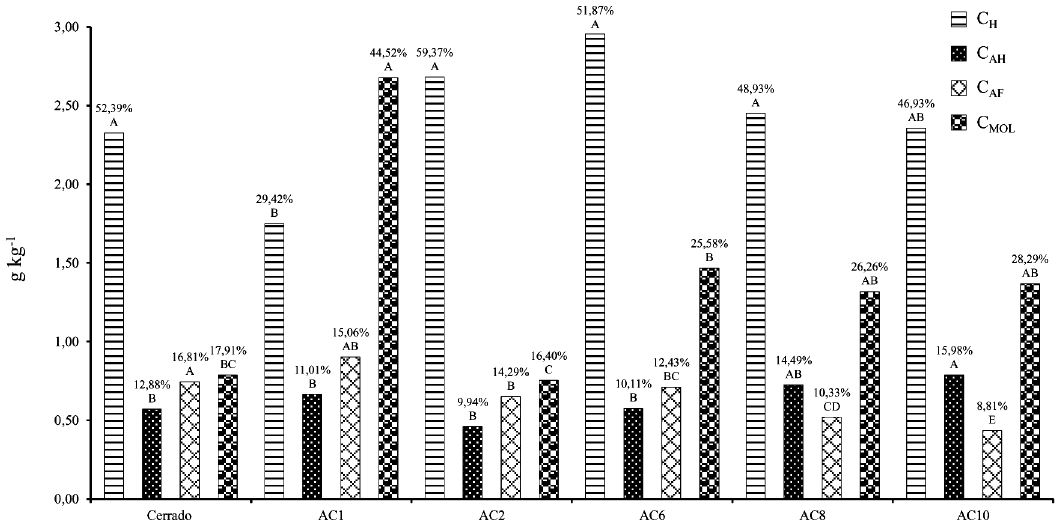
Figura 3. Distribuição de carbono na forma de humina (C H ), carbono na forma de ácidos húmicos (C AH ), carbono na forma de ácidos fúlvicos (C AF ) e carbono na forma de matéria orgânica leve (C MOL ), na profundidade de 0-20 cm de um Neossolo Quartzarênico, em diferentes áreas de cultivo de soja e milheto. AC1: área de cultivo com um ano, AC2: área de cultivo com dois anos, AC6: área de cultivo com seis anos, AC8: área de cultivo com oito anos, e AC10: área de cultivo com 10 anos. Médias não seguidas pela mesma letra maiúscula, entre as épocas e para cada fração, diferem estatisticamente entre si pelo teste Mann- Whitney a 5